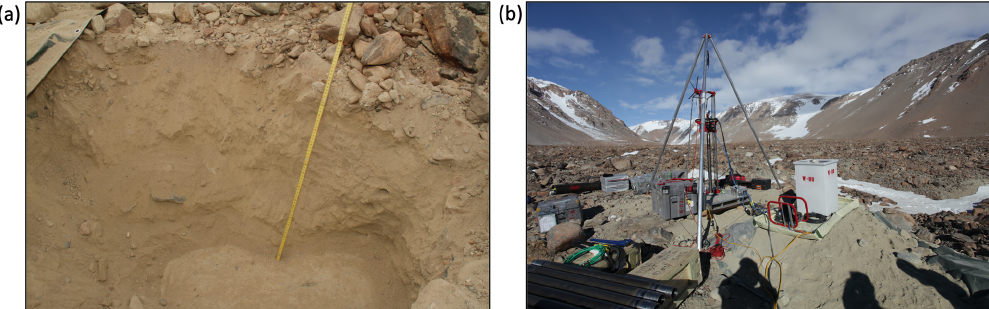
Figure 3. Photographs of the drill site 17-OD1. (a) Excavated pit for sampling of the supraglacial debris. The Middle drift ice surface is found at the bottom of the pit. The yellow ruler in the image measure ∼ 60cm from the bottom of the pit to the surface of the supraglacial debris. (b) Winkie drill installed above the excavated pit for ice coring. Photograph looking